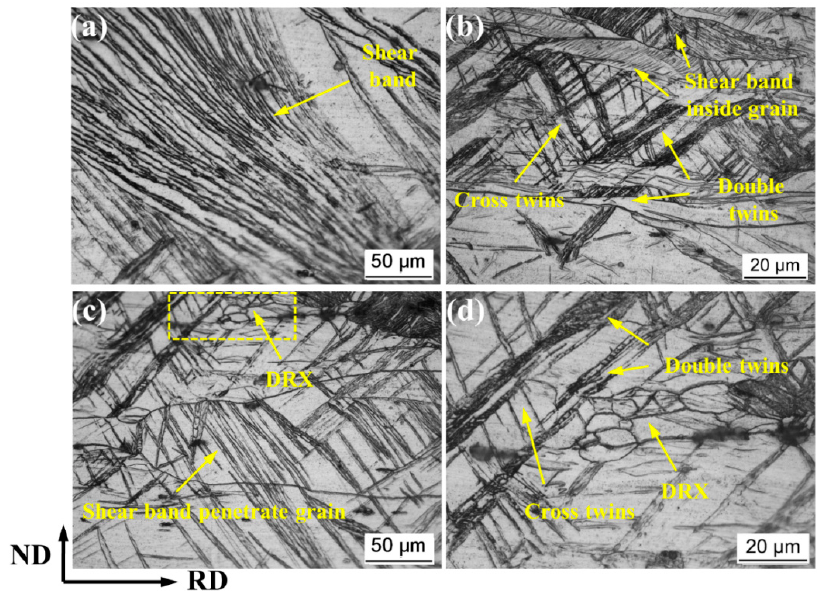
Figure 3. Detailed metallographic microstructure of RR30%: ( a ) shear band, ( b ) twins and shear band, ( c ) shear band penetrate grain, and ( d ) recrystallization.